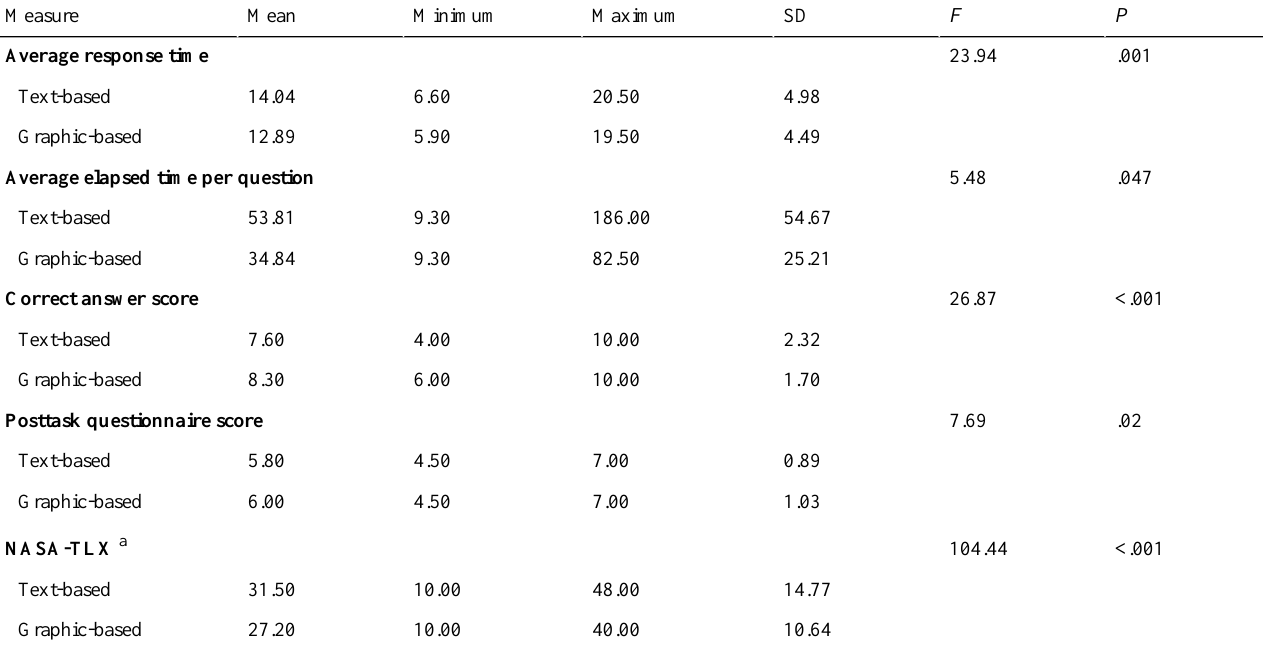
Table 3. Results compariosn between text- and graphic-based experiements.